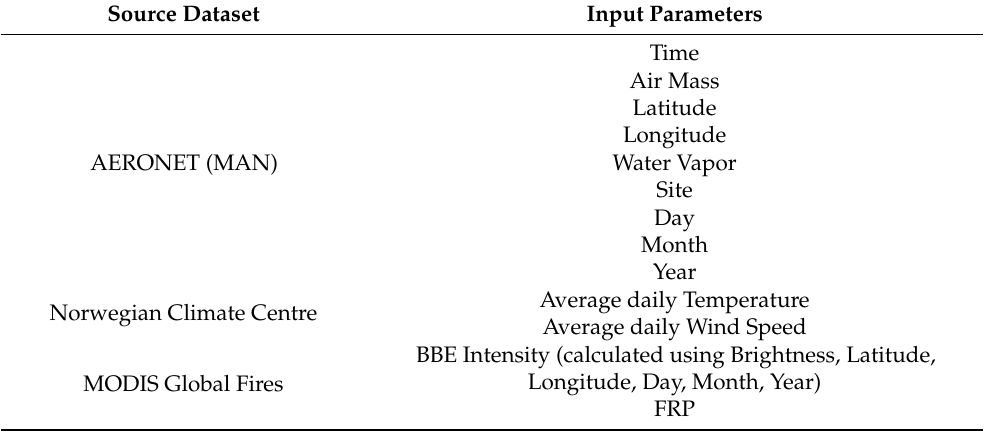
Table 1. Input parameters.